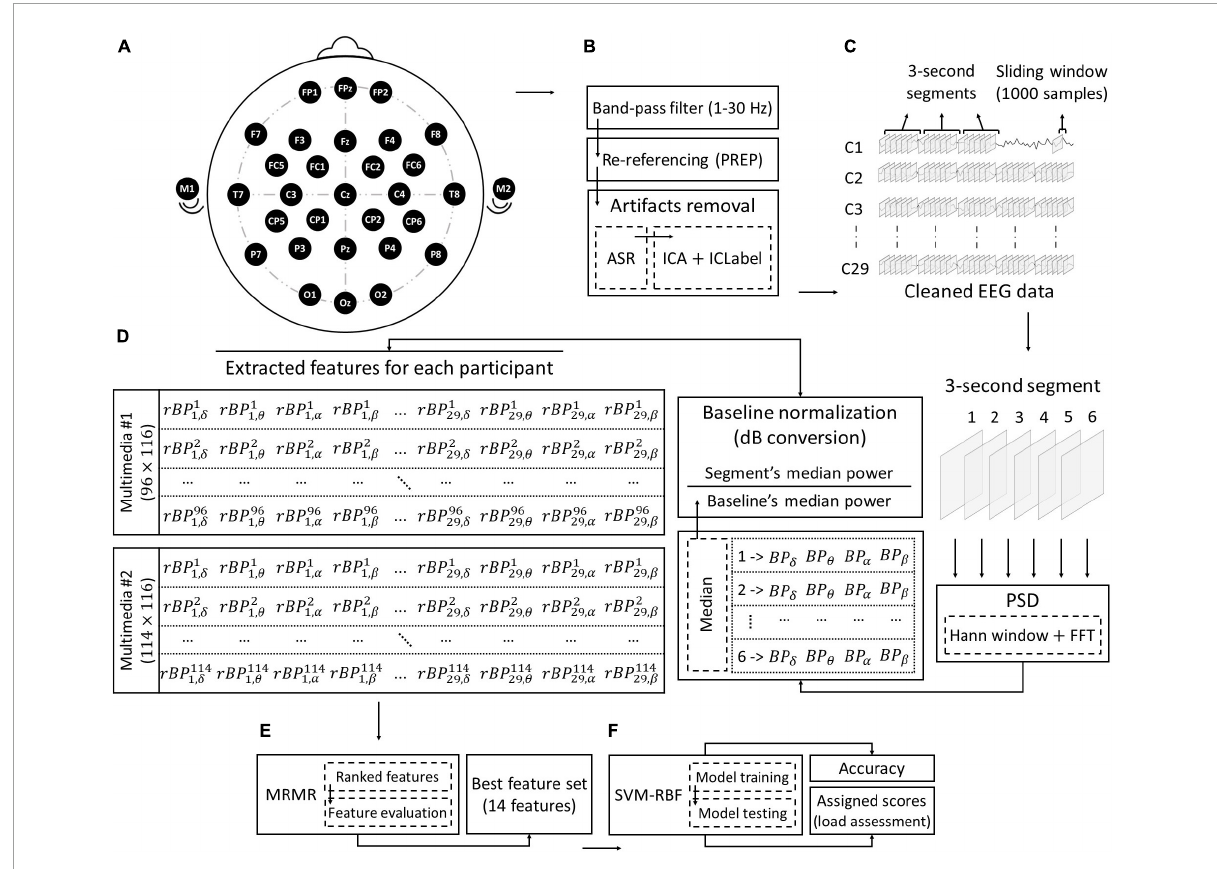
FIGURE3 Electroencephalography (EEG) analysis workflow. (A) EEG acquisition: data collected from 29 channels for each participant during displaying the multimedia. (B) Pre-processing: includes band-pass filter, re-referencing, and artifacts removal processes. (C) Data segmentation: a sliding window (size = 1,000 ms ; 50% overlappings) moves on the signal of each channel. Each of the six adjacent windows forms a 3s segment. (D) Feature extraction: by performing Hann window and by using the FFT method, PSD of all frequency sub-bands is calculated for each window. Next, the ratio of the median power of each 3s segment to the median power of the baseline is considered as the relative band power (rBP) of that segment. For each rBP, the superscript shows the segment number and the subscripts show the channel number and the band, respectively. Finally, the extracted features of each participant for each of the multimedia will be formed in 96 × 116 and 114 × 116 dimensions for multimedia 1 (i.e., LV1 and HV1) and multimedia 2 (i.e., LV2 and HV2), respectively. (E) Feature selection: the best set of features will be selected by evaluating the importance of the features which is ranked by the MRMR algorithm. (F) Classification: an SVM (kernel: RBF) is built to assign a score to each segment (assessment of instantaneous cognitive